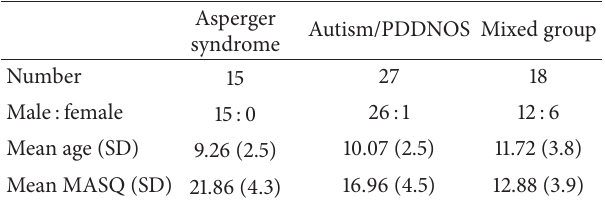
Table 1: MASQ scores of the three groups.